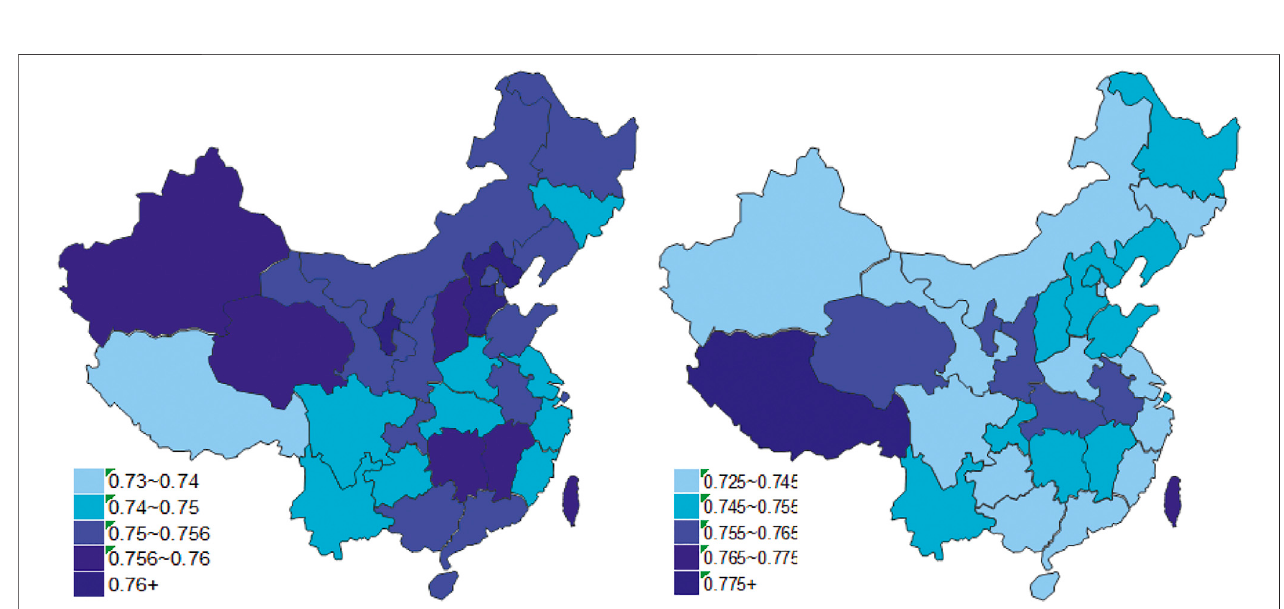
FIGURE 7 | The comparison of average network diameter between 2011 and 2019.